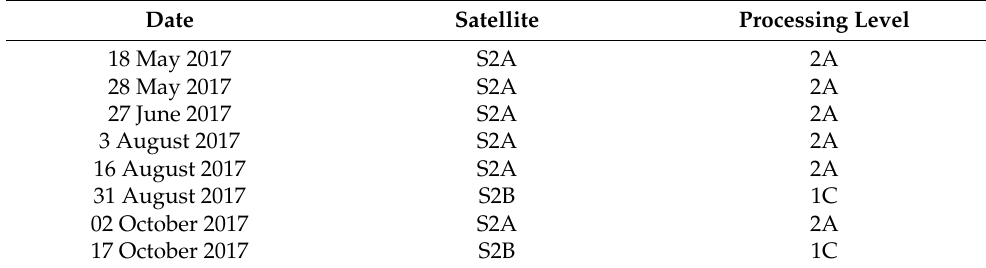
Table 2. Dates and main satellite data characteristics.